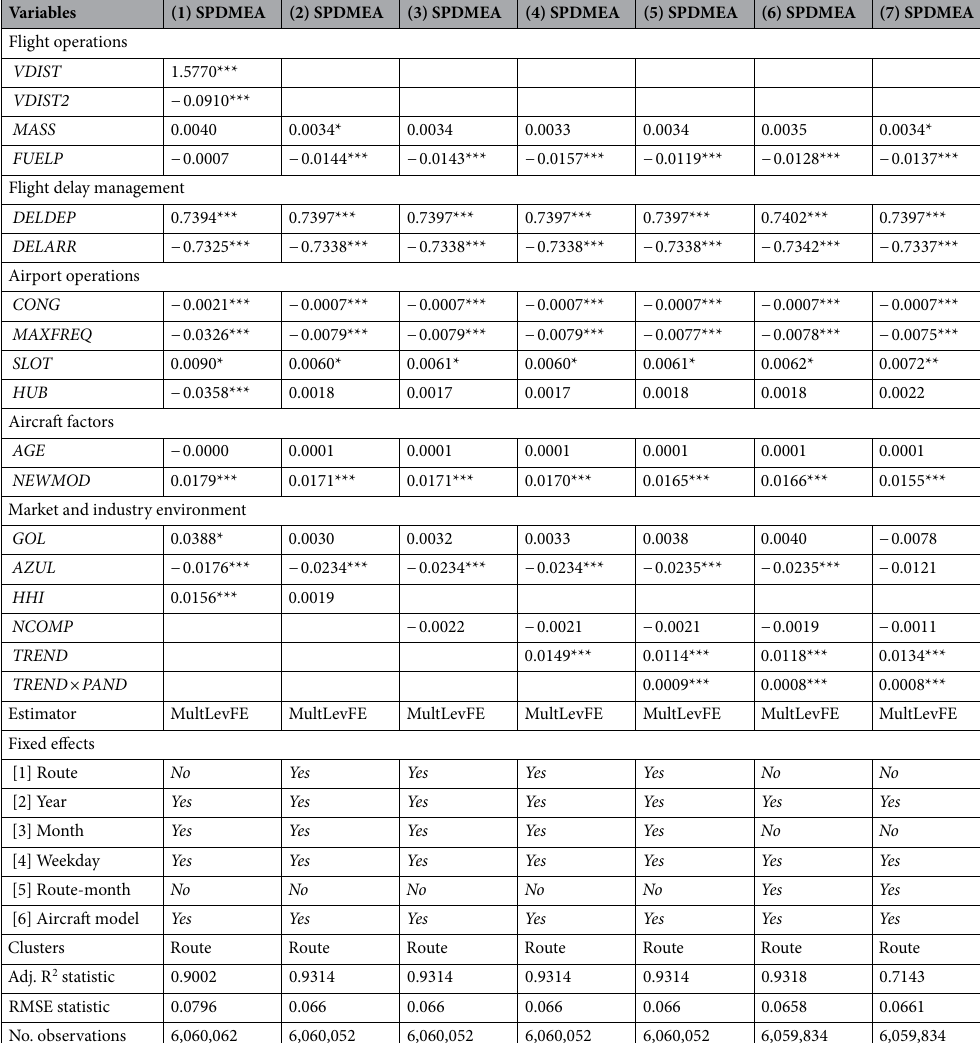
Table 2. Estimation results: flight mean speed ( SPDMEA , DSPDMEA ). Results produced by linear regression absorbing multiple levels of fixed effects (MultLevFE) of Correia 37 . Std. errors adjusted for route clusters. The no. of observations across columns may vary due to singleton drops. p-value representations: ***p < 0.01, **p < 0.05, *p < 0.10. Significant values are in